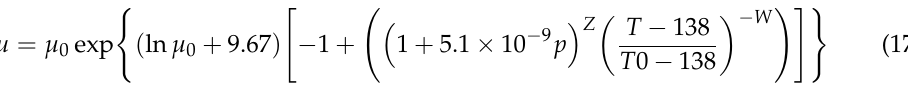
8 of 17 Figure 5. Pressure field, elastic deformation, and temperature field: ( a ) Predicted by the fluid model; ( b ) predicted by the fluid–structure–thermal interaction model; ( c ) the elastic deformation of the piston’s surface; ( d ) the elastic deformation of the bushing’s surface; ( e ) the temperature distribution of the film; and ( f ) the dynamic viscosity distribution of the film. The pressure can lead to the elastic deformation of the structure. On the other hand, the elastic deformation of the structure changes the film height and the pressure distribu- tion until the pressure distribution and the elastic deformation do not change. The elastic deformation due to the pressure field is instantaneous, but it is an iterative process to